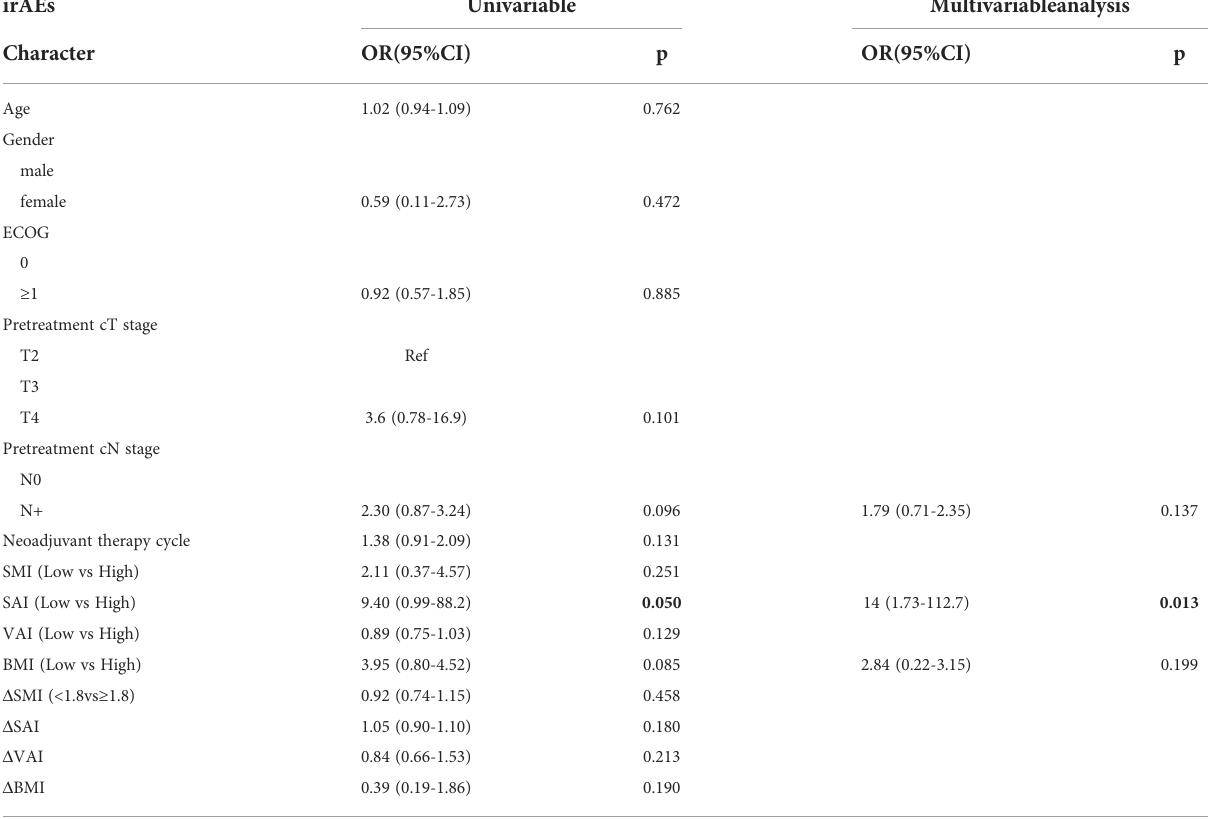
TABLE 5 Univariate and multivariable analysis of the relationship between body composition with